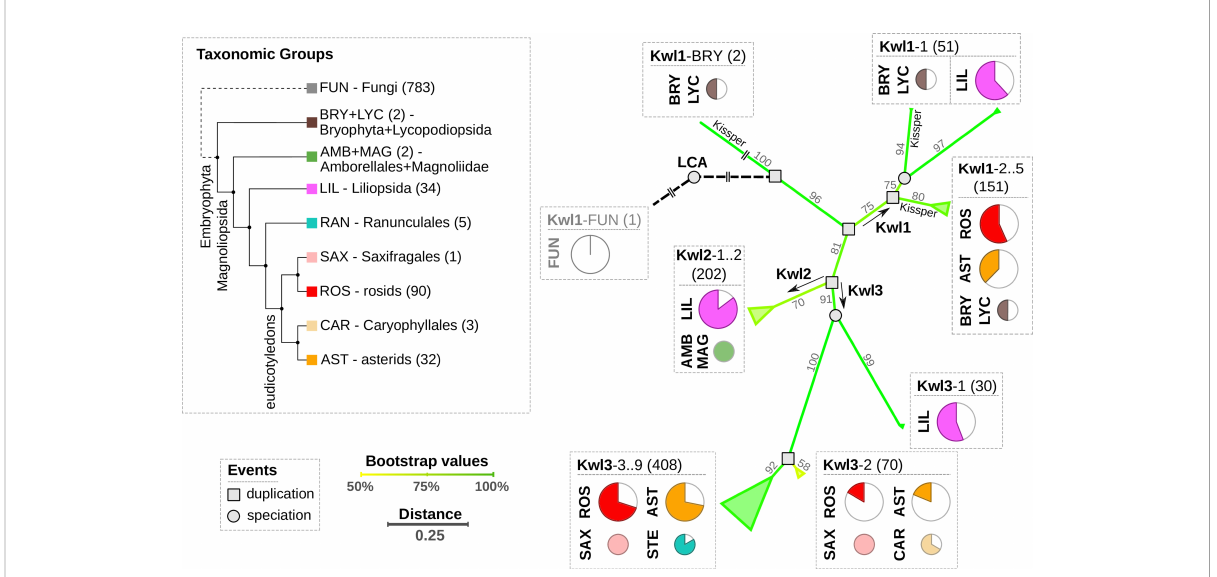
FIGURE 2 Left panel: Cladogram of the relevant taxonomic groups. The number of respective species in our data set is indicated in brackets. Right panel: Summary of the phylogenetically reconciled Kiwellin tree. The edge color and numbers refer to bootstrap percentages. Evolutionary events are indicated by a circle (speciation) or a square (duplication). Pie charts visualize the species coverage. Groups that mostly contain Kissper-Kiwellins are indicated (Kissper).